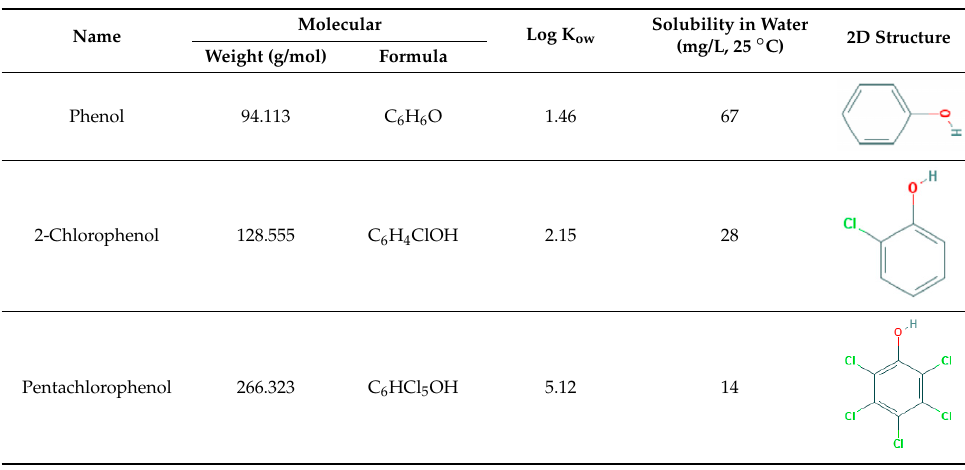
Table 6. Characteristics of Phenol, 2-Chlorophenol, and Pentachlorophenol [26].